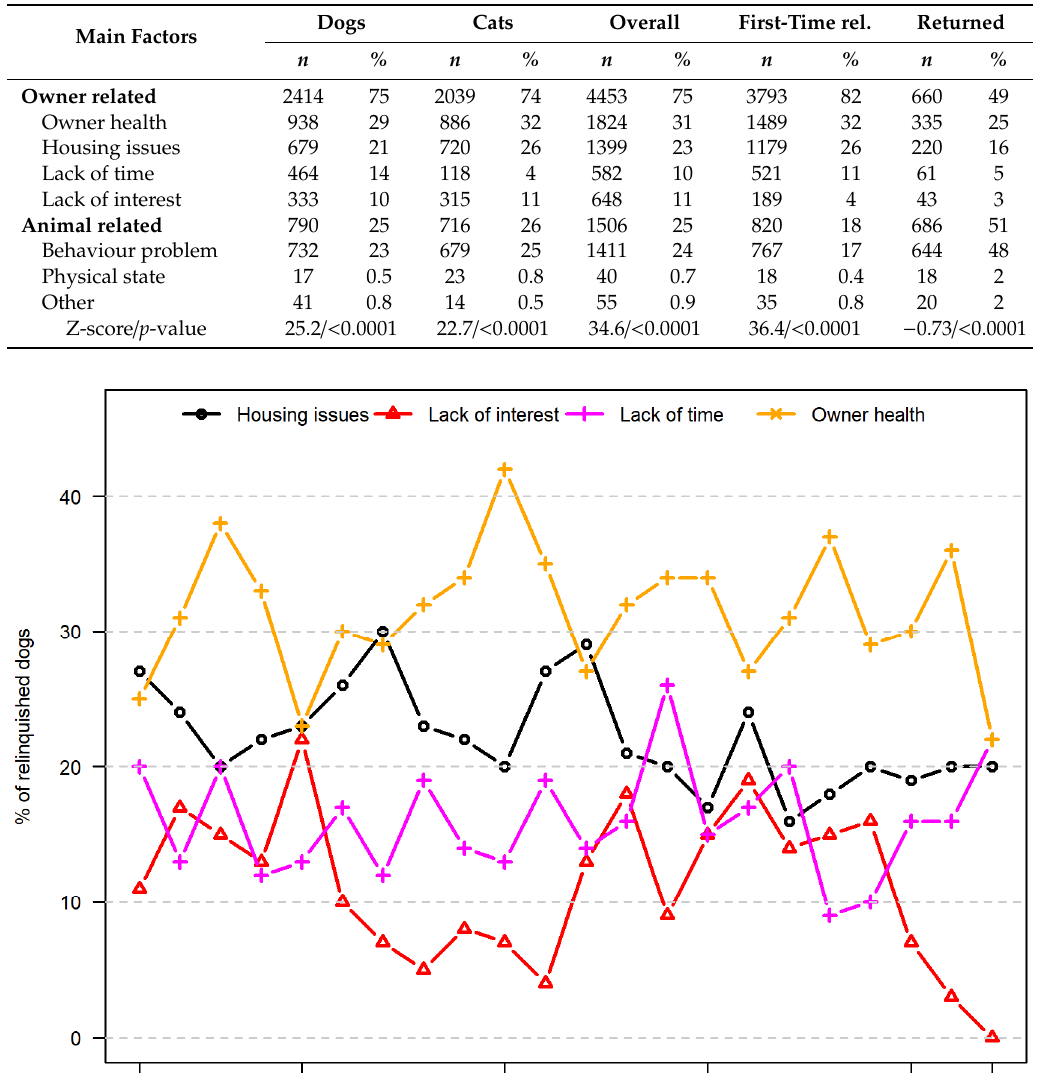
factors was equal to the observed proportion of animal factors.